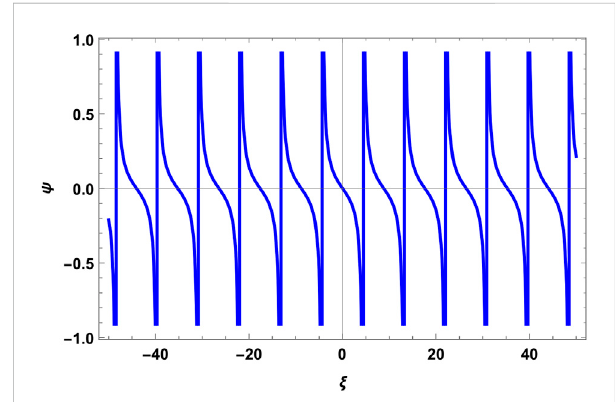
FIGURE 1 Periodic solution Sn for plasma parameters α =0.1, β =0.026, γ =0.7, δ =0.01, μ =0.1, ] =0.9, and m (cid:2) 1